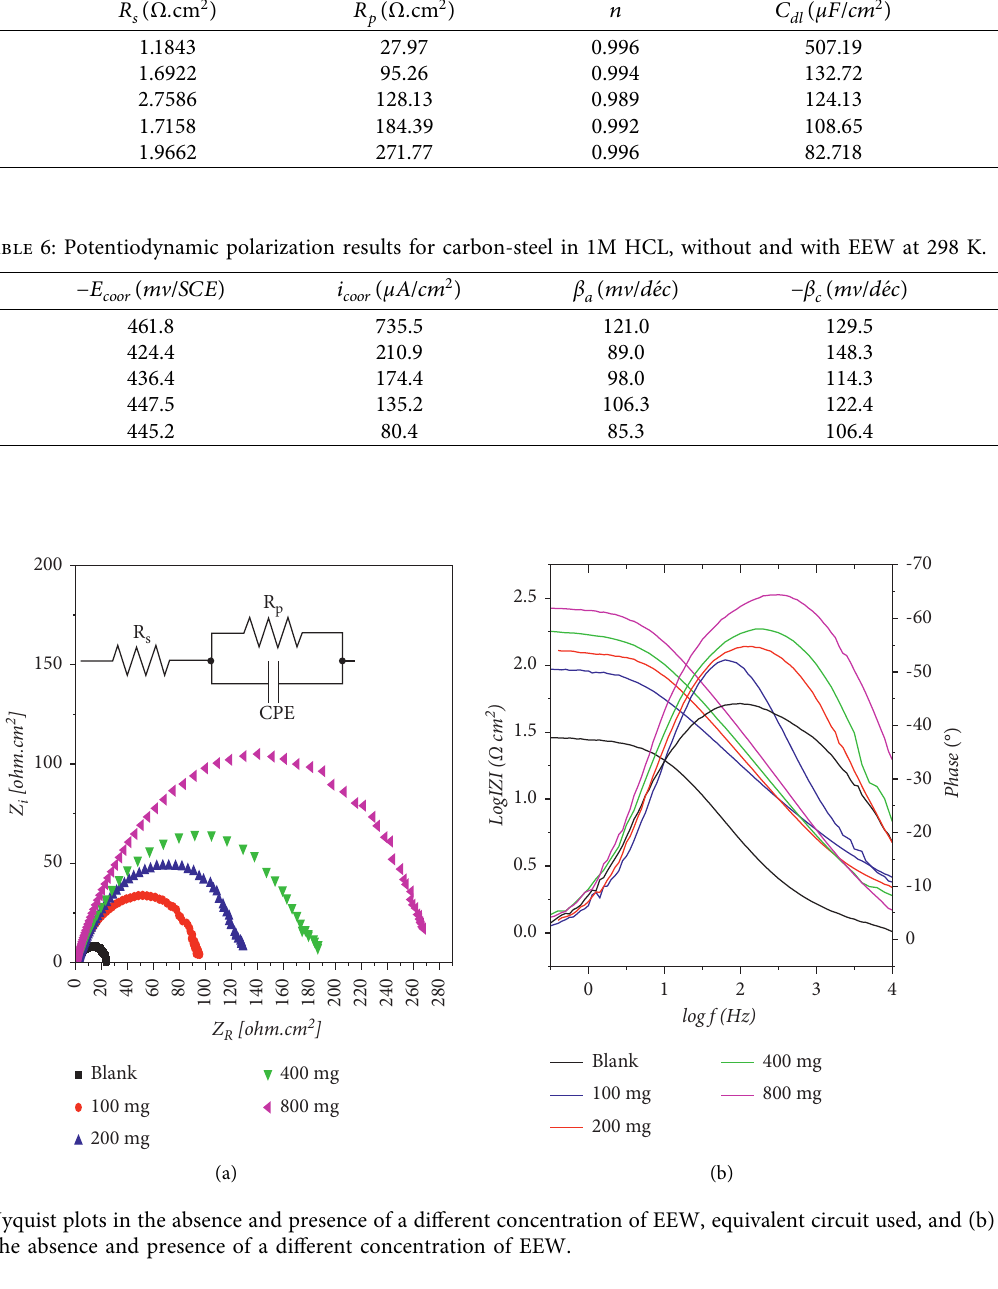
Table 5: Electrochemical parameters of impedance for carbon-steel in 1M HCL, without and with EEW at 298 K. ( mg.l − 1 C inh